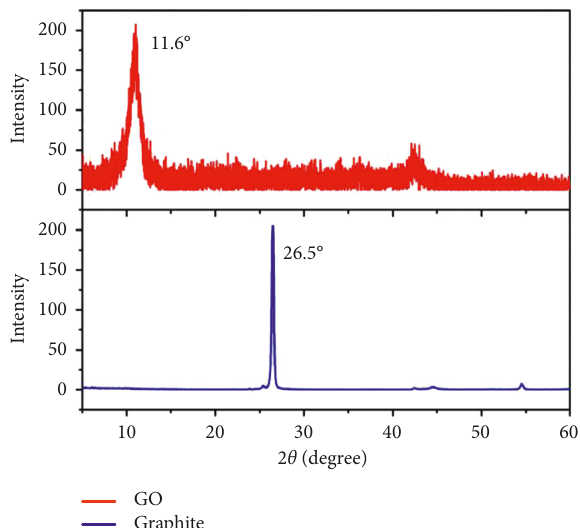
Figure 1: XRD patterns of graphite powder and GO.